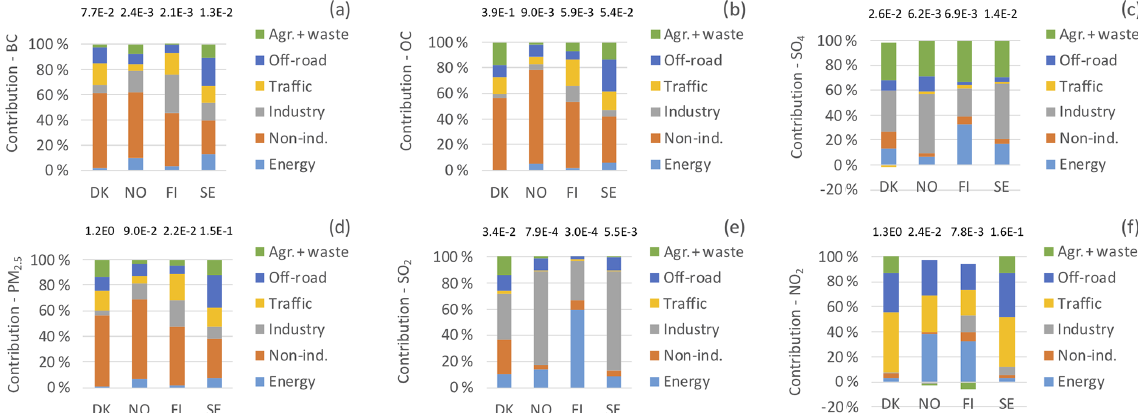
Figure 6. Population-weighted sectoral contributions of Danish emissions on surface (a) BC, (b) OC, (c) SO 4 , (d) PM 2 . 5 , (e) SO 2 and (f) NO 2 over the Nordic countries. The labels above the bars show the absolute total contribution in µgm − 3 from all the sectors in Denmark.